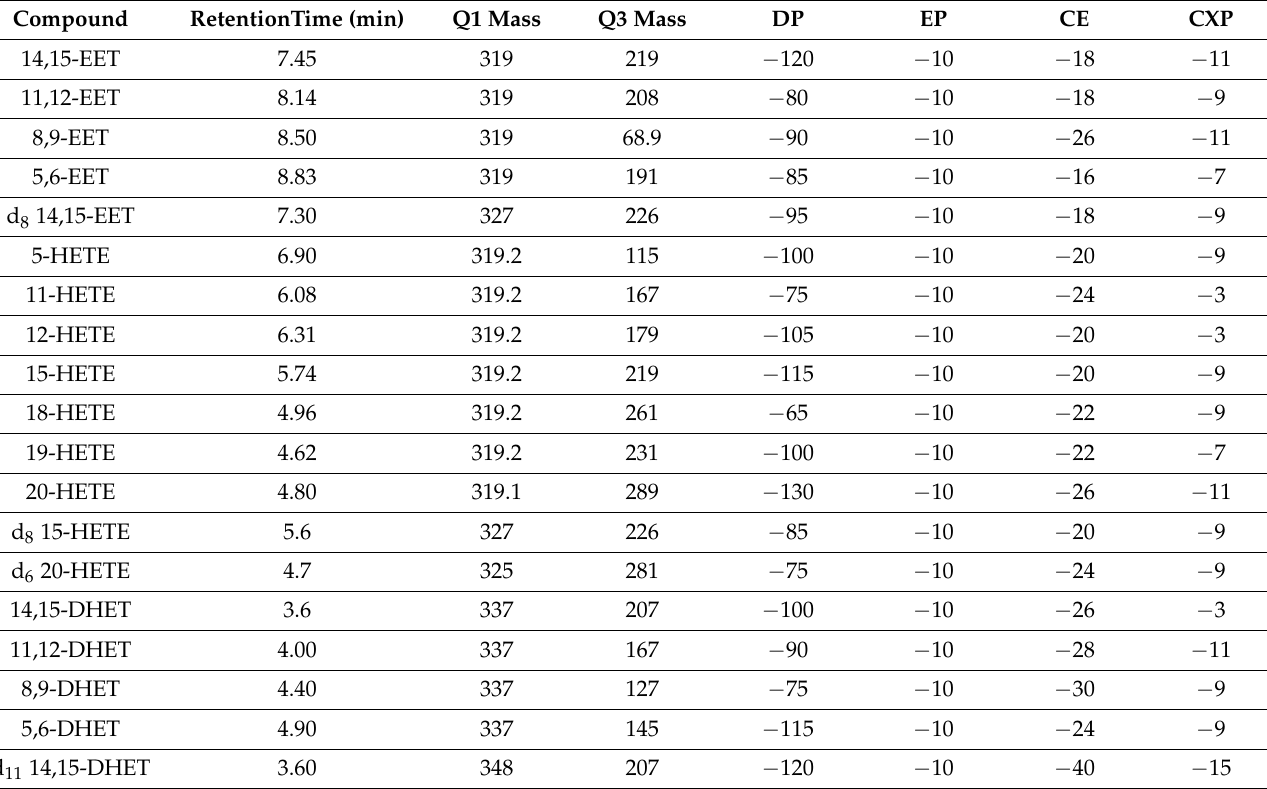
Table 1. MRM parameter for the analysis of arachidonic acid